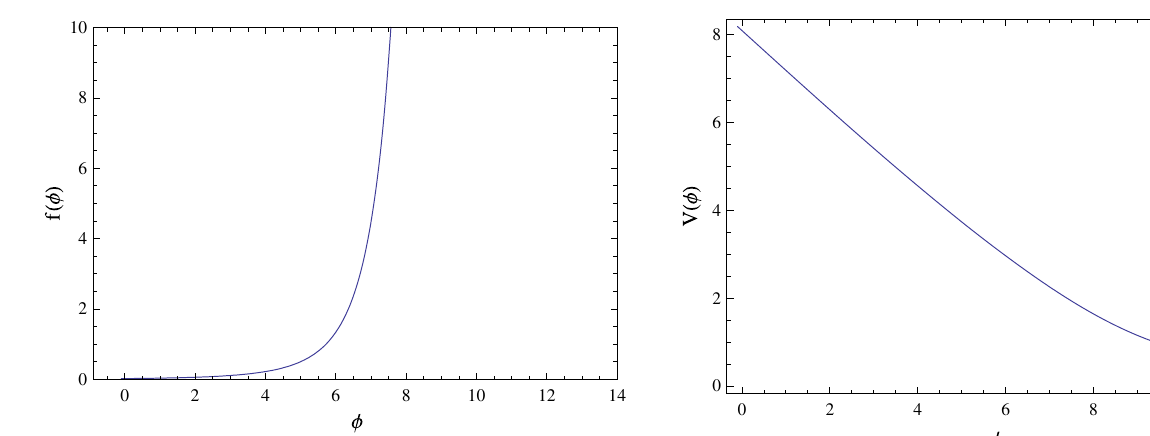
(φ) with the variation of φ for the Efstathiou parameterization (Model